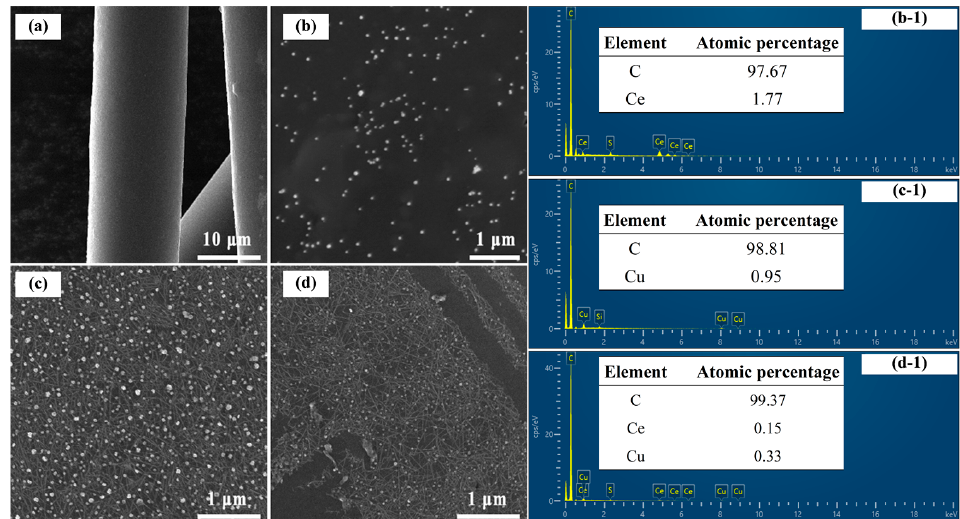
Figure 1. SEM–EDS images of ( a ) ACF, ( b ) N-CNF/ACF@Ce, ( c ) N-CNF/ACF@Cu and ( d ) N-